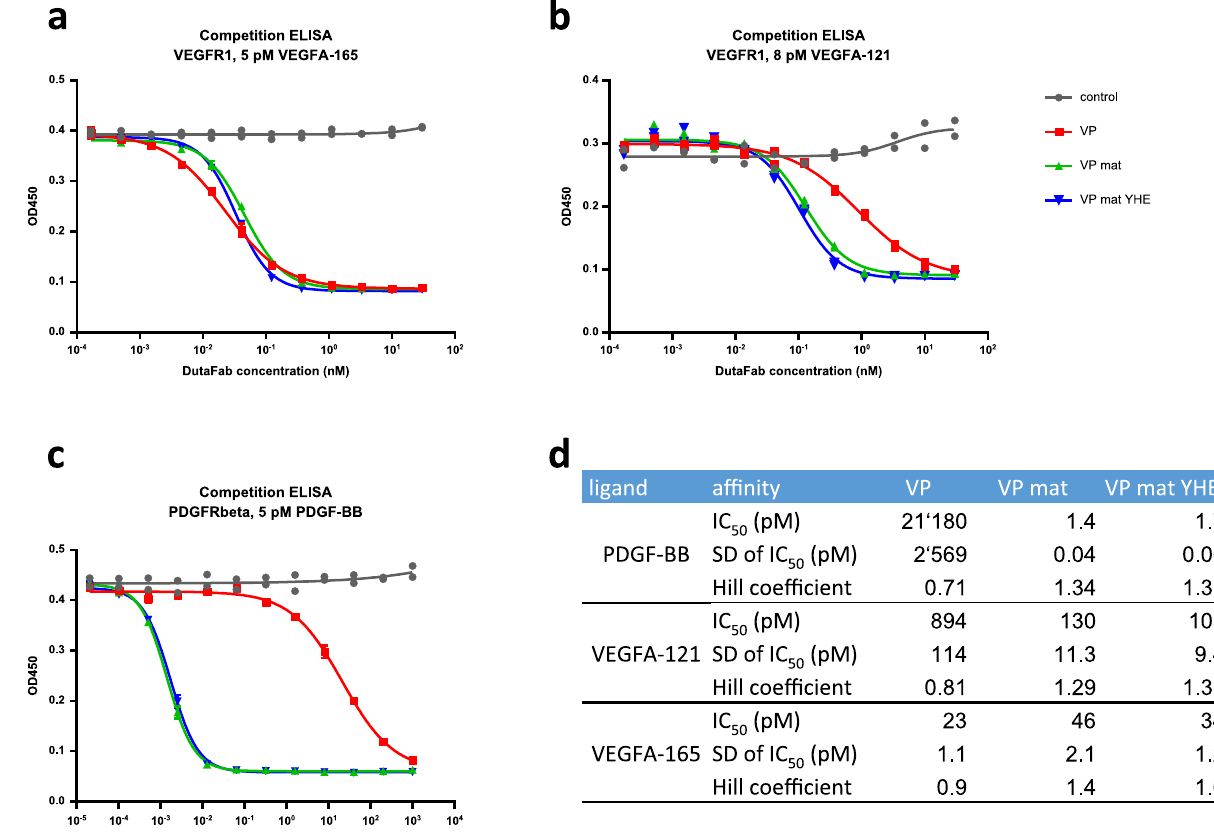
Fig. 3 Af fi nity maturation of the VEGF-PDGF DutaFab. The potency of the original bispeci fi c DutaFab VP was signi fi cantly increased towards both PDGF- BB and VEGFA-121 by af fi nity maturation of both paratopes. Af fi nity maturation of either paratope did not negatively impact potency on the opposite paratope. a Competition ELISA with VEGFR1-Fc and 5 pM VEGFA-165. b Competition ELISA with VEGFR1-Fc and 8 pM VEGFA-121. c Competition ELISA with PDGFR β -Fc and 5 pM PDGF-BB. d Tabulated curve fi t parameters. SD = standard deviation. A sample size of n = 2 independently prepared samples was